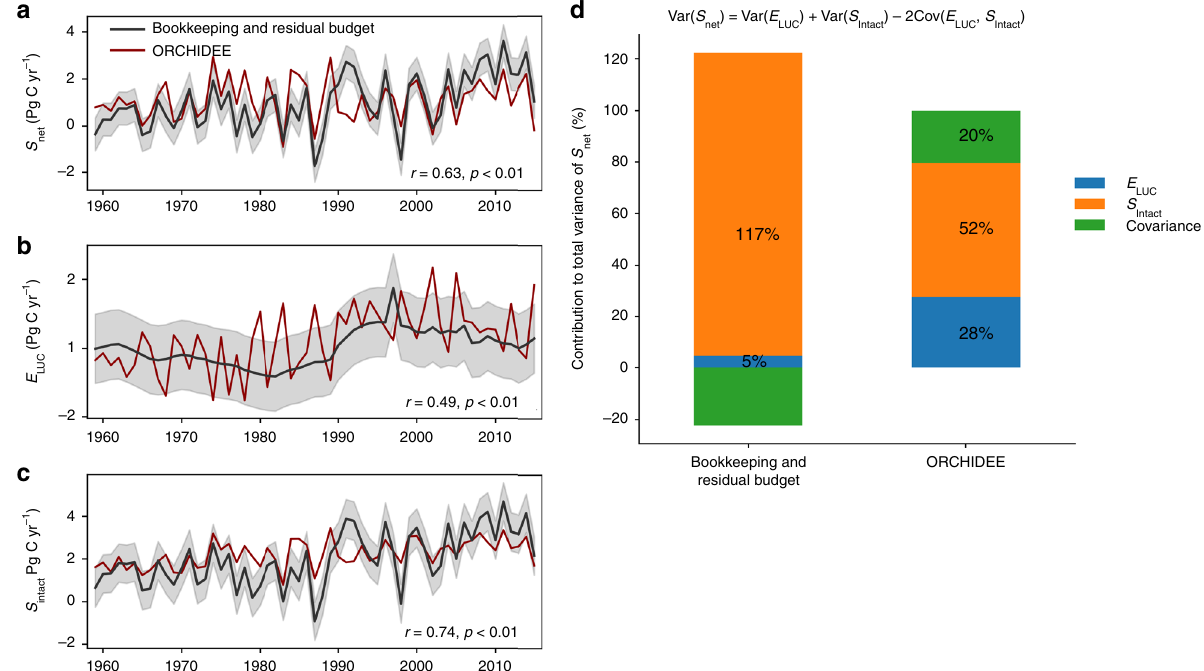
Fig. 6 Attribution of S net and its variance into E LUC and S Intact . a S net . b E LUC . c S Intact . Data were shown for 1959 – 2015. The red line indicates ORCHIDEE result; the black line shows the result, following the bookkeeping and residual budget approach (i.e., IPCC AR5 and ref. 14 ), with shaded gray areas indicating the uncertainty of one standard deviation. Pearson correlation coef fi cients ( r ) between the two estimates are shown, with the period of 1991 – 1993 under strong Pinatubo in fl uence being excluded when calculating r ( n = 54, p -value calculated as a two-sided p -value). d shows the decomposition of temporal variances (Var) of S net into the variances of E LUC , S Intact , and their covariance ( n = 57, Eq. (5) in “ Methods ”